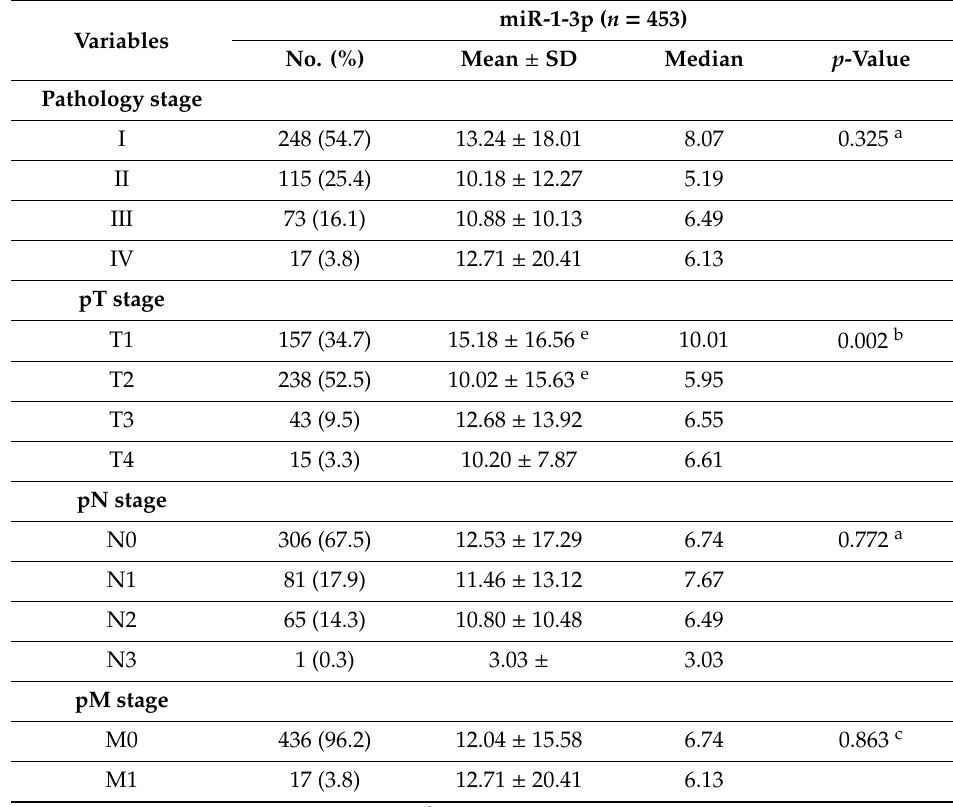
Table 4. Correlation of miR-1-3p expression with clinicopathological characteristics of 453 lung cancer patients.